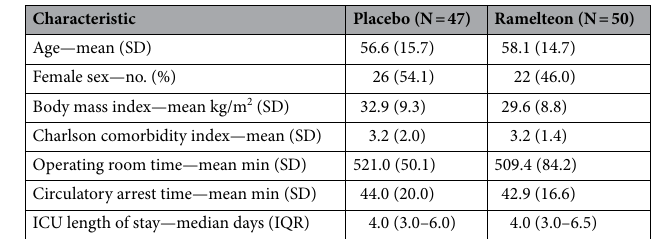
Table 1. Baseline characteristics of patients receiving placebo vs.